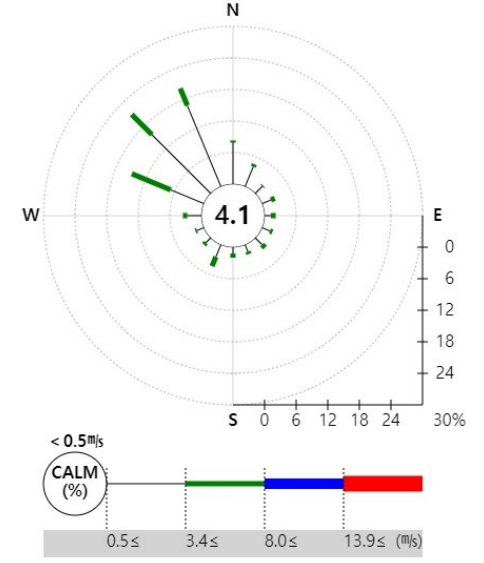
Figure 5. Wind rose of chemical accident period (1 January 2017–8 April